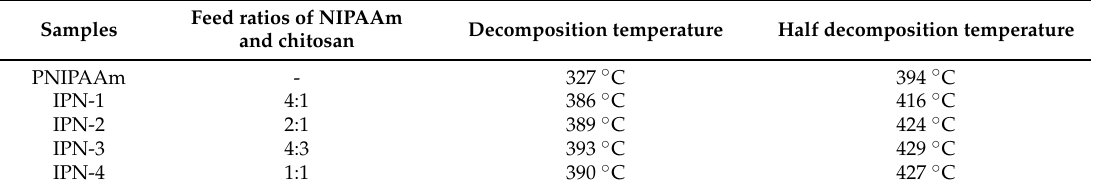
Table 1. TGA information of